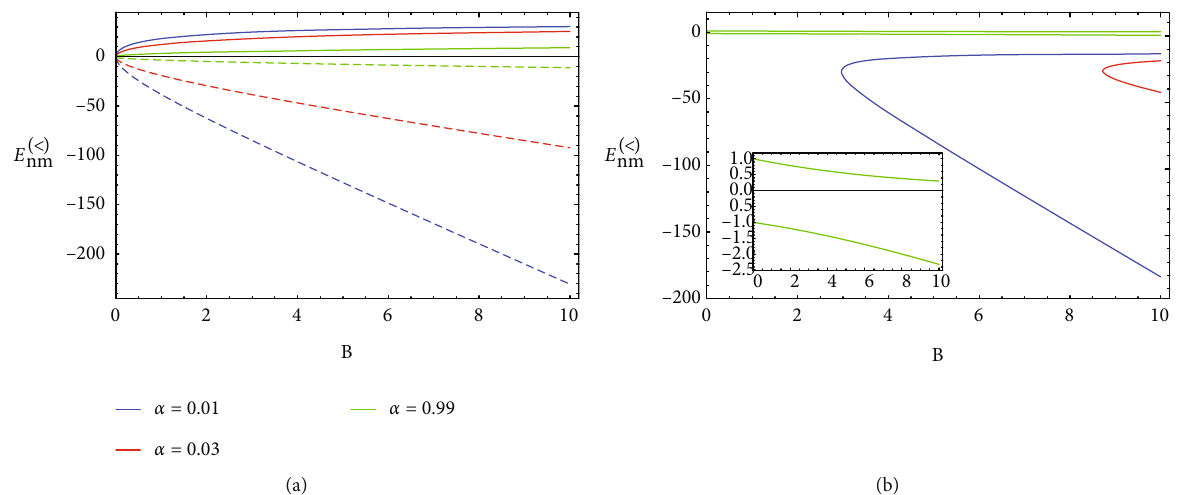
Figure 5: Sketch of the energy (Equation (71)) as a function of B for n = 1 , m = 1 , a = 0 : 1 , and di ff erent values of α . In panel (a), ϕ = 5 , and in panel (b), ϕ = 0 . With the presence of Aharonov-Bohm fl ux, the energy of the state for a particular value of alpha is permissible for any value of B . In the absence of Aharonov-Bohm fl ux, the energy of a state with a particular value of α is nonpermissible for some values of B (blue and red lines on panel (b)). For ever decreasing α values, the antiparticle energy is more impacted. When α approaches 1 and the fl ux is zero, the modi fi cation in the energy levels is small (see the inset in panel (b)).